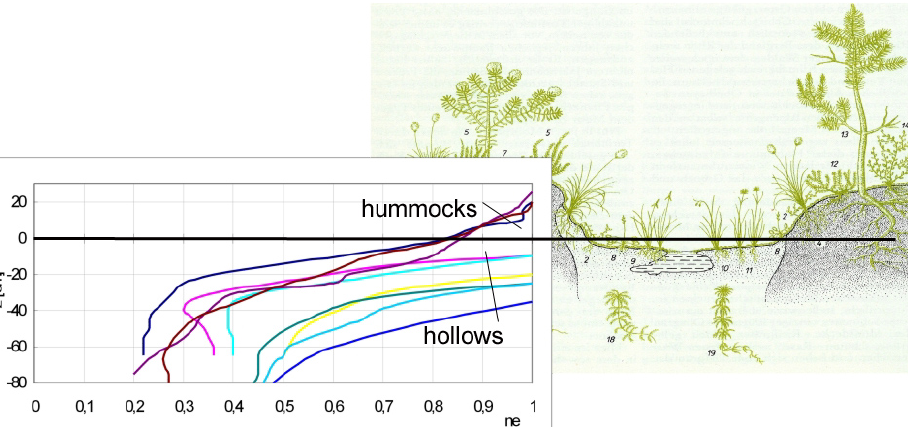
Fig. 3. Depth-functions of the drainable porosity n e for hummocks and hollows, combined from Ivanov and Novikov (1976) and Slo- bodda